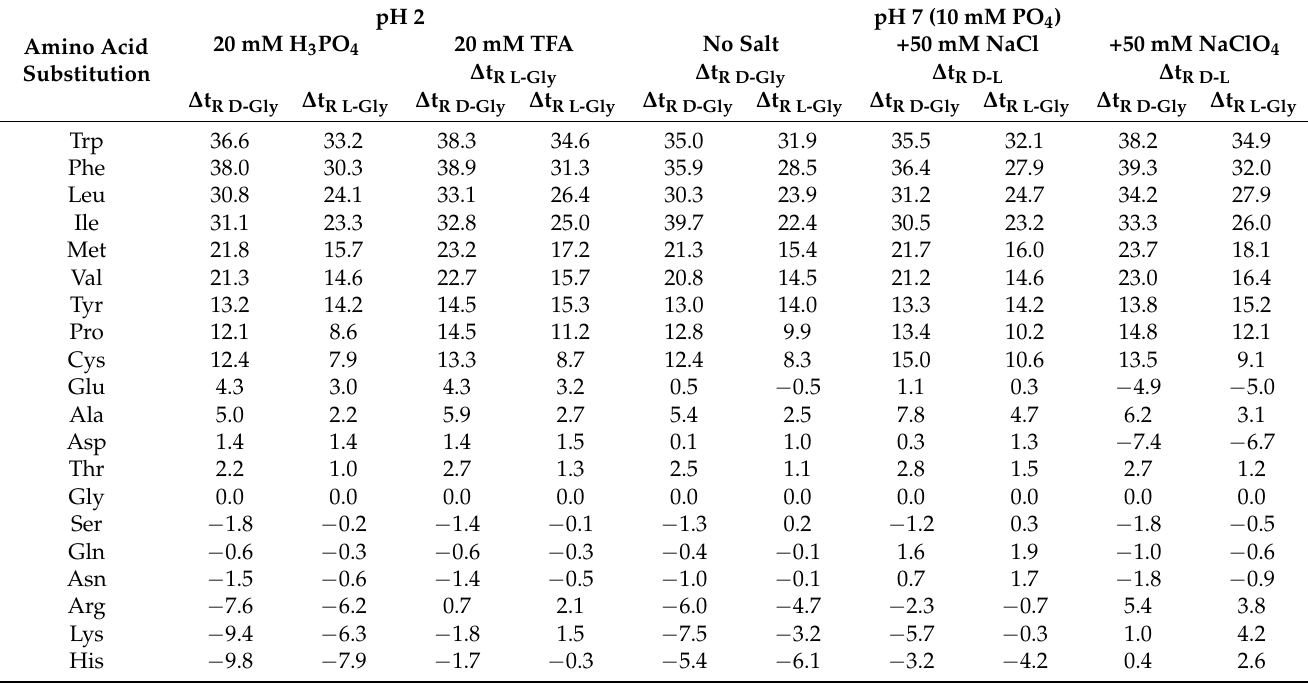
Table 12. Retention coefficients of amino acids